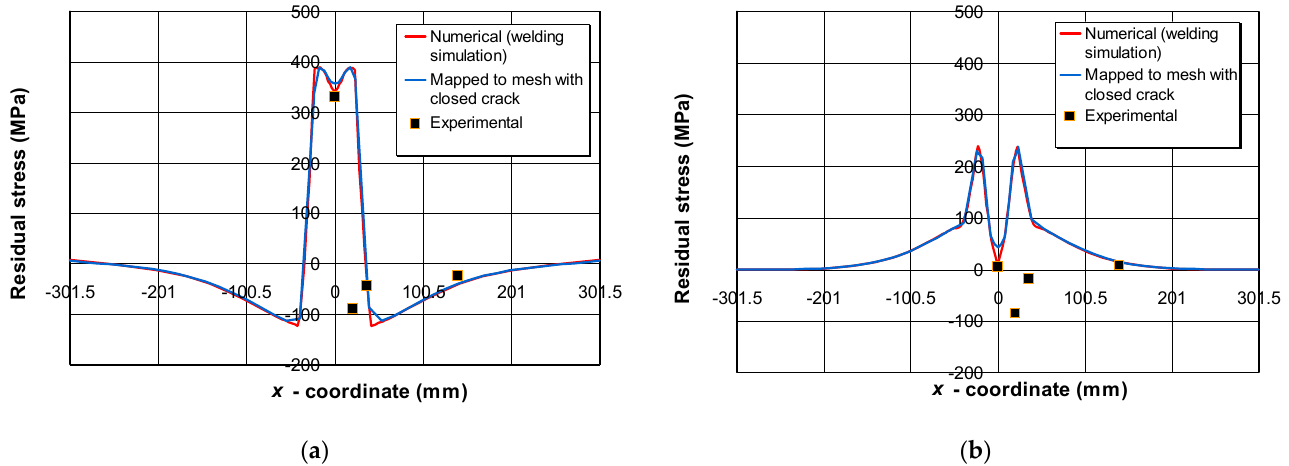
Figure 5. Residual stress profiles at the bottom surface along line A-A shown in Figure 1 in comparison with experimental measurements: ( a ) longitudinal stress, ( b ) transversal stress.